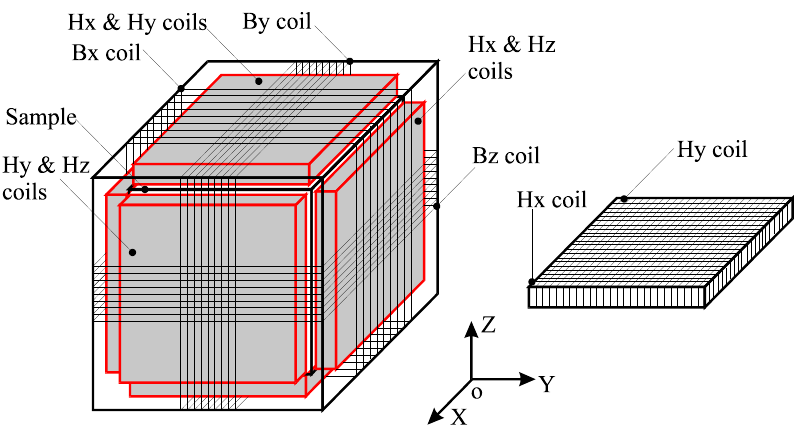
Figure 3. A cubic material sample with B and H sensing coils.